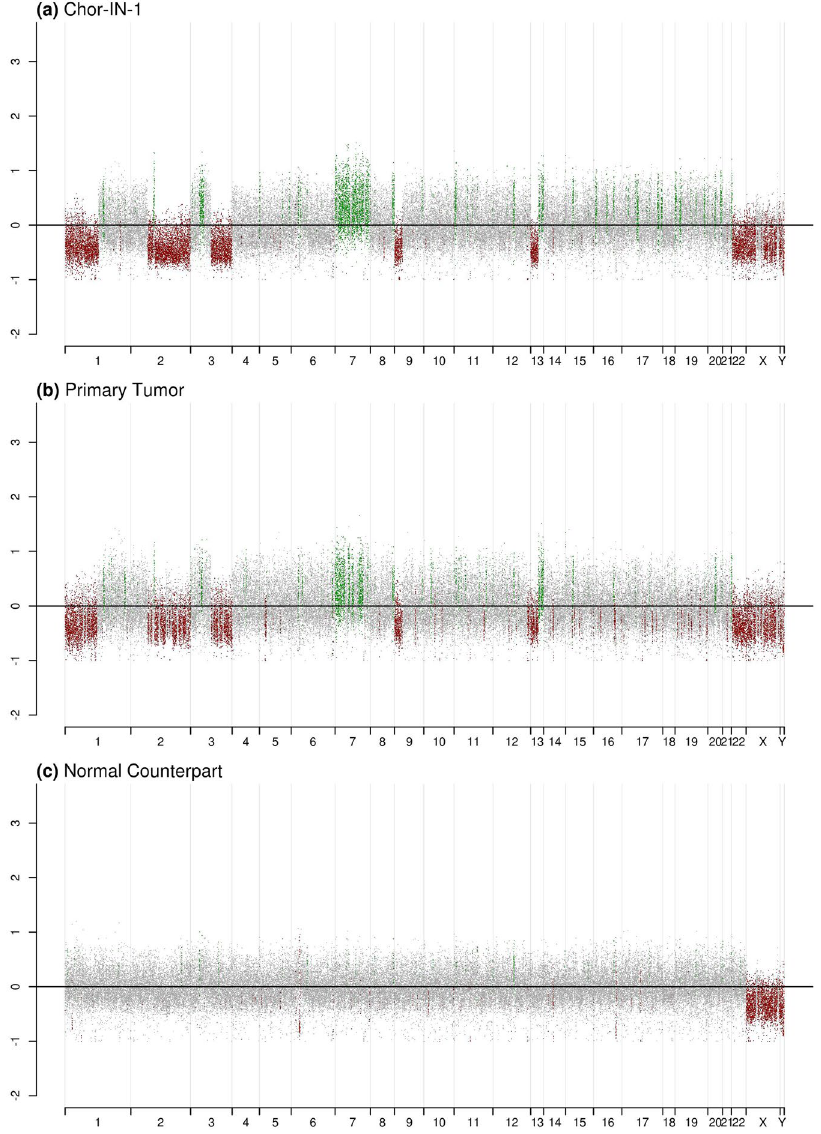
Figure 3. Genomic profile of Chor-IN-1 cell line and original tumor.Copy number profiles obtained by NGS analysis on: ( a ) the newly established Chor-IN-1 cell line, ( b ) the primary tumor of origin, ( c ) the normal tissue counterpart. Log2 ratio of the coverage in each interval vs medium coverage is reported in the plot. Regions with chromosomal gain (log2 ratio > 0.2) are reported in green, while regions of chromosomal loss (log2 ratio < − 0.2) are reported in red. Balanced genomic regions are reported in